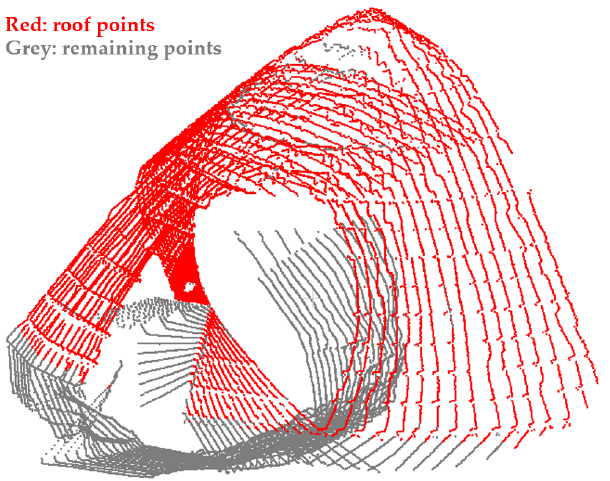
Figure 12. A sample roof segmentation result for a LiDAR scan in the West Lafayette dataset.